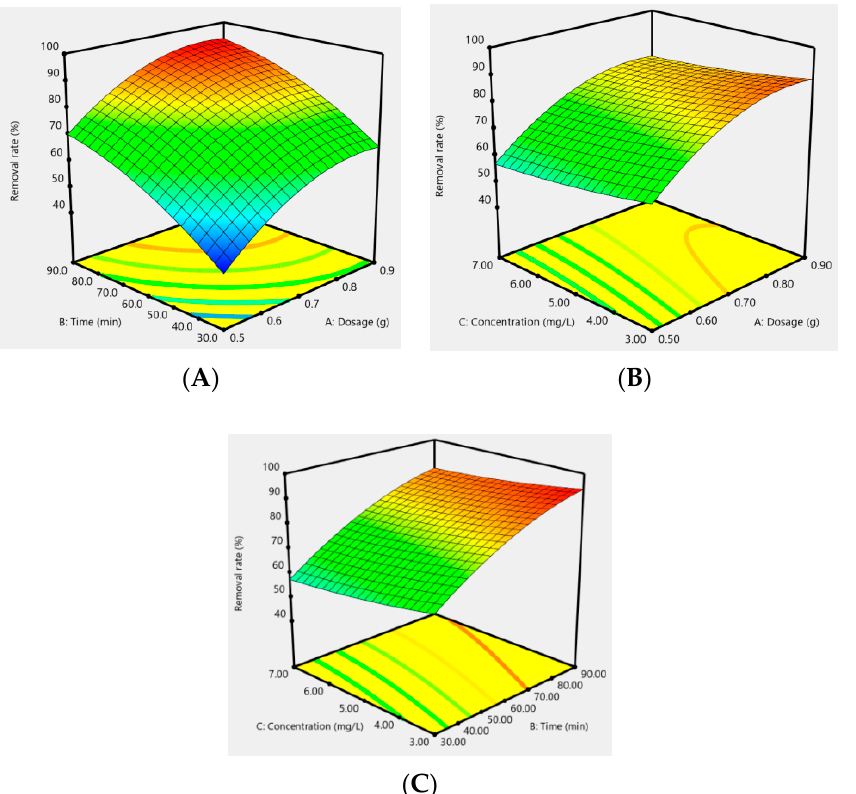
Figure 12. Response surface of the dosage ( A ), contact time ( B ), and concentration ( C ) of AC-CuO on the removal effect of methylene blue.